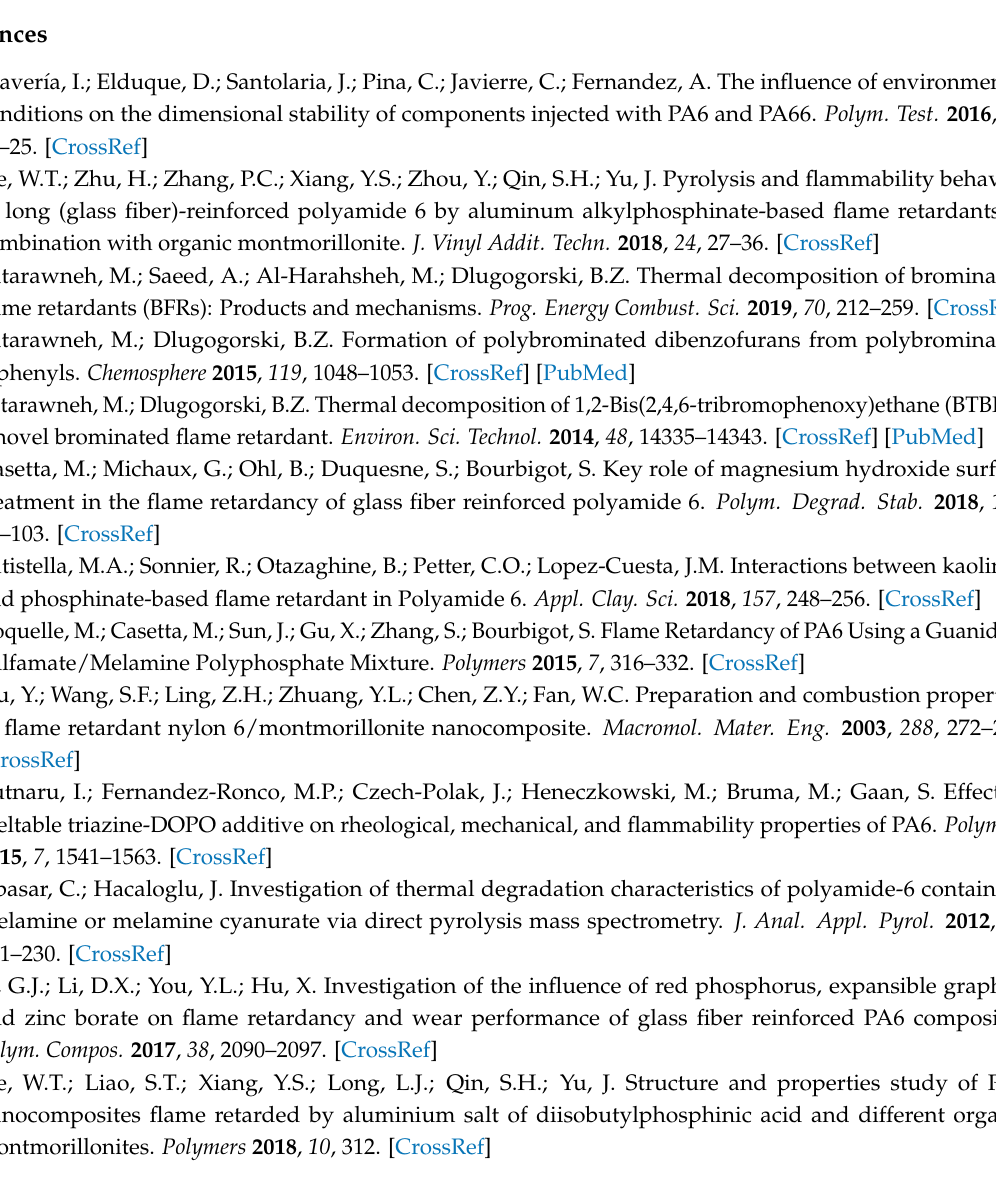
Figure S1. Figure S1. FTIR spectrum of API, Figure S2. Figure S2. Solid-state 13C NMR spectrum of